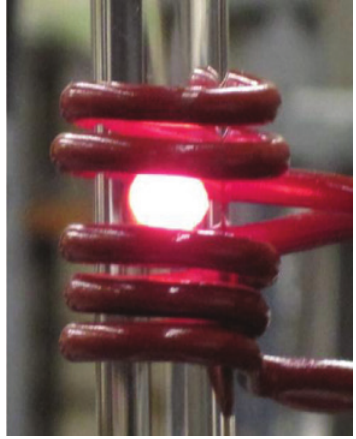
Fig. 8: Heating profiles for silicon-iron droplets containing 15%